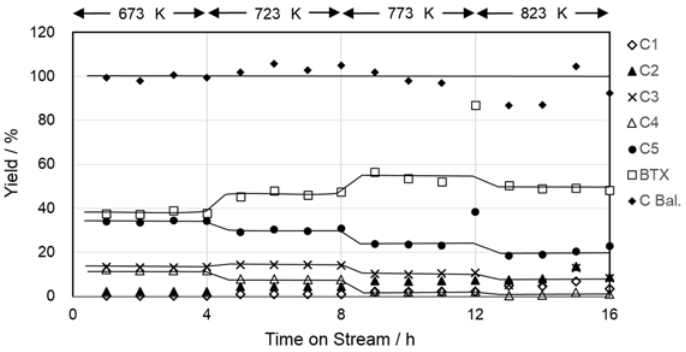
Figure 1. Change in the product distribution in the reaction of 2-octanol on Zn-MFI as a function of reaction temperature and time. Reaction conditions: catalyst, Zn-MFI with a silica/alumina ratio 40 and Zn 0.67 wt. %, 0.50 g; total gas flow rate, 20 mL·min − 1 (GHSV 1400 h − 1 ); P 2OcOH 5%; N 2 95%; 1